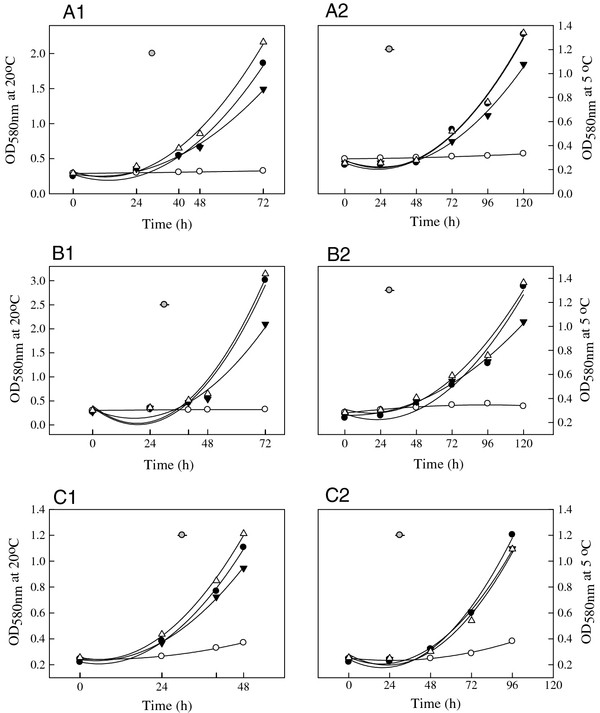
Influence of BLS-producing LAB on fungal growth (a1, a2 = M. fructicolaat 20 or 5°C;b1, b2 = B. cinereaat 20 or 5°C; c1, c2 = P. expansumat 20 or 5°C) after incubation at 20°C for 72 h or 5°C for 120 h. Positive control = Fungal spores grown in MRS broth (●), fungal spores in untreated LAB CFS (○), fungal spores in pH neutralized CFS (▼), fungal spores in CFS after pH neutralization and H2O2 elimination (Δ). The vertical bar represents standard errors of mean.